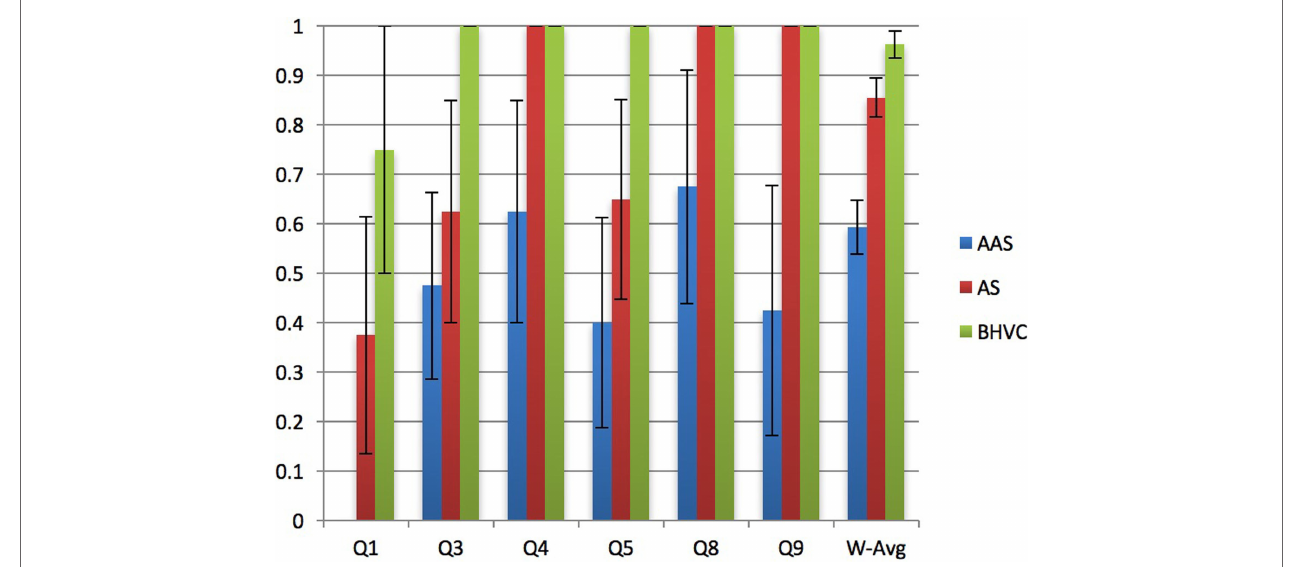
FigUre 6 | average grades (with se bars) secured by the participants with the three interaction techniques for only significant or close-to- significant p Values ( < 0.1) .